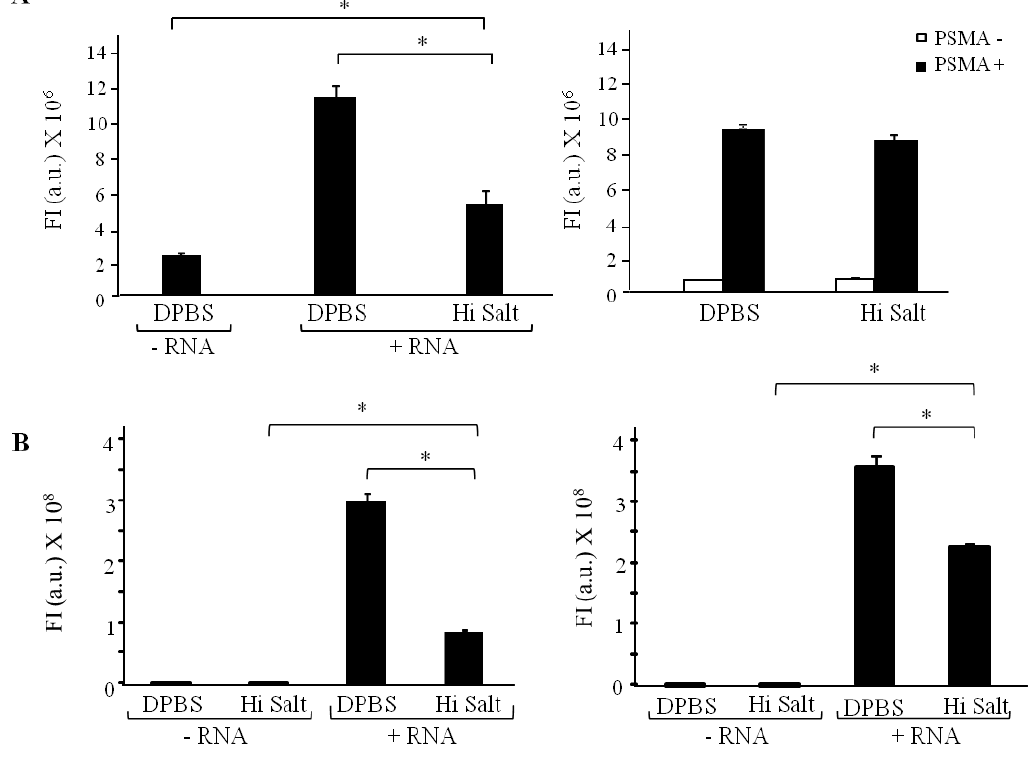
Figure 3. Plate-reader assay to assess aptamer binding and internalization. For the binding experiments, cells were fixed to inhibit active transport before incubation with the RNA aptamers. Live cells were used for the internalization experiments. ( A ) Binding ( left ) and internalization ( right ) of A9g into PSMA-expressing prostate cancer cells. ( B ) Binding ( left ) and internalization ( right ) of E1 aptamer into rat HER2-expressing mammary carcinoma cells. Cells only (no RNA) controls were carried out for each condition. Fluorescence was measured using an Analyst HT plate reader. (*, p <